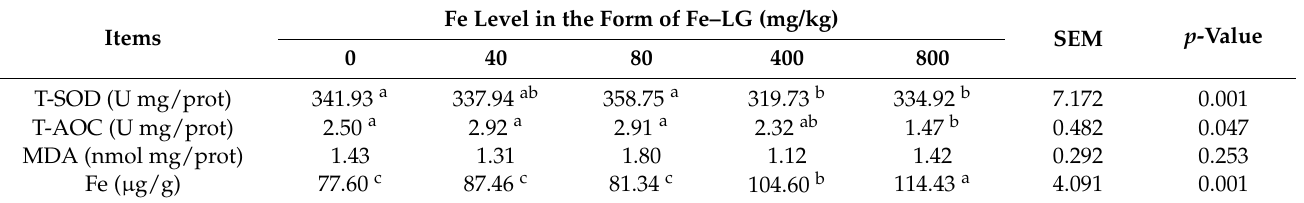
Table 9. Effects of dietary supplementation with high doses of Fe–LG on antioxidant index and iron content in liver of 42-day-old broilers 1